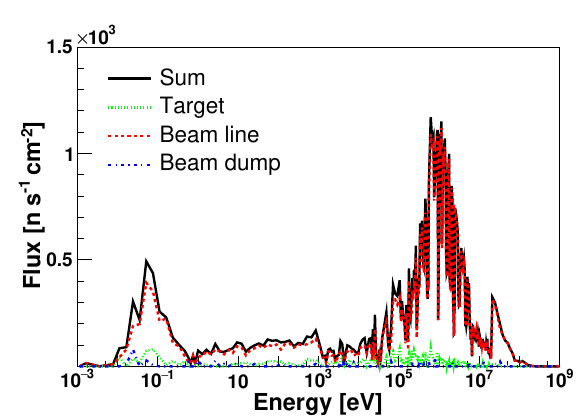
Figure 2. The simulated neutron energy spectra at the MAGNEX FPD region. The spectrum corresponding to neutrons emerging from the beam-target interaction, the beam dump and the hy- pothetical 10W loss are denoted with the dotted green, dotted- dashed blue and dashed red lines, respectively.The sum of the three contributions is presented with the solid black line. Figure from Ref. [7].